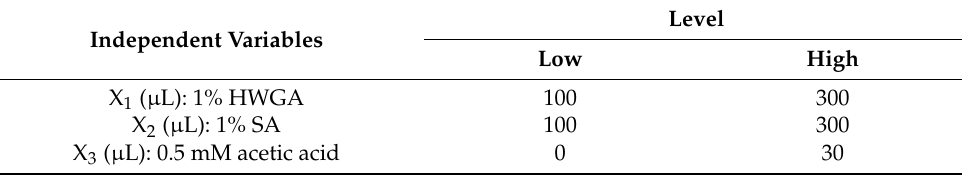
Table 3. Independent variables and their levels in the response surface experimental design.